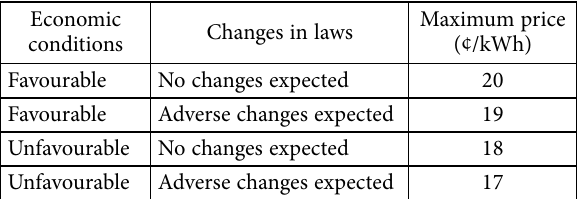
Table 2. The maximum prices for different scenarios